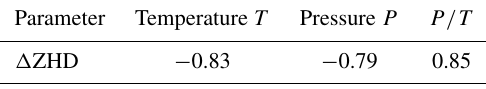
Table 1. Correlation coefficients between the ZHD offset and tem- perature and pressure.